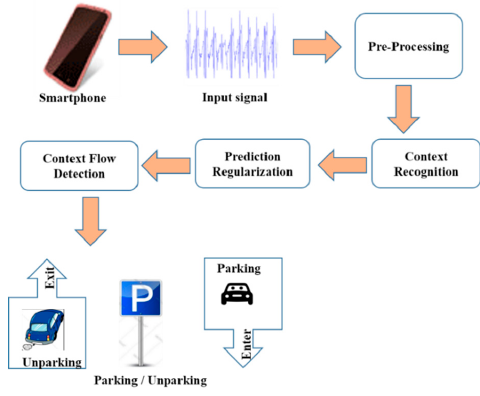
Figure 6. Major steps of the proposed system.